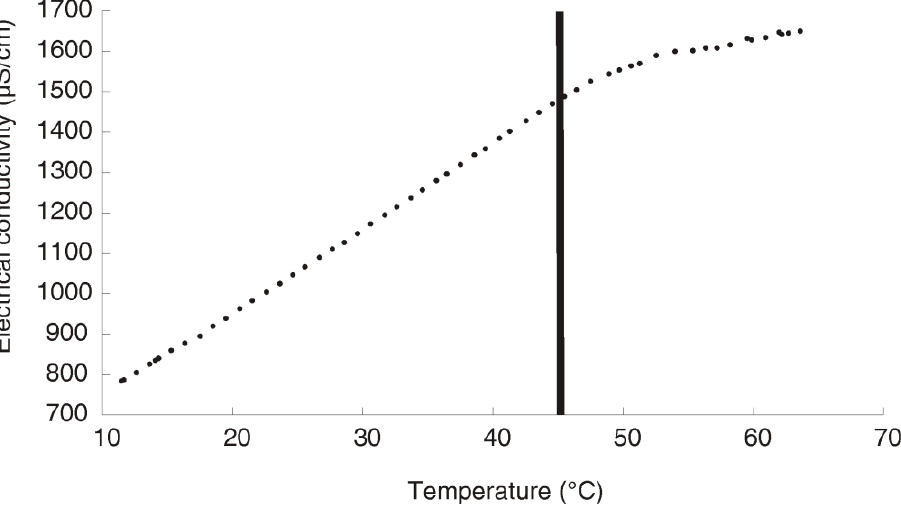
Figure 10. Water electrical conductivity increases with temperature but with a non-linear behaviour. Consequently, the fractional change per degree Celsius m with